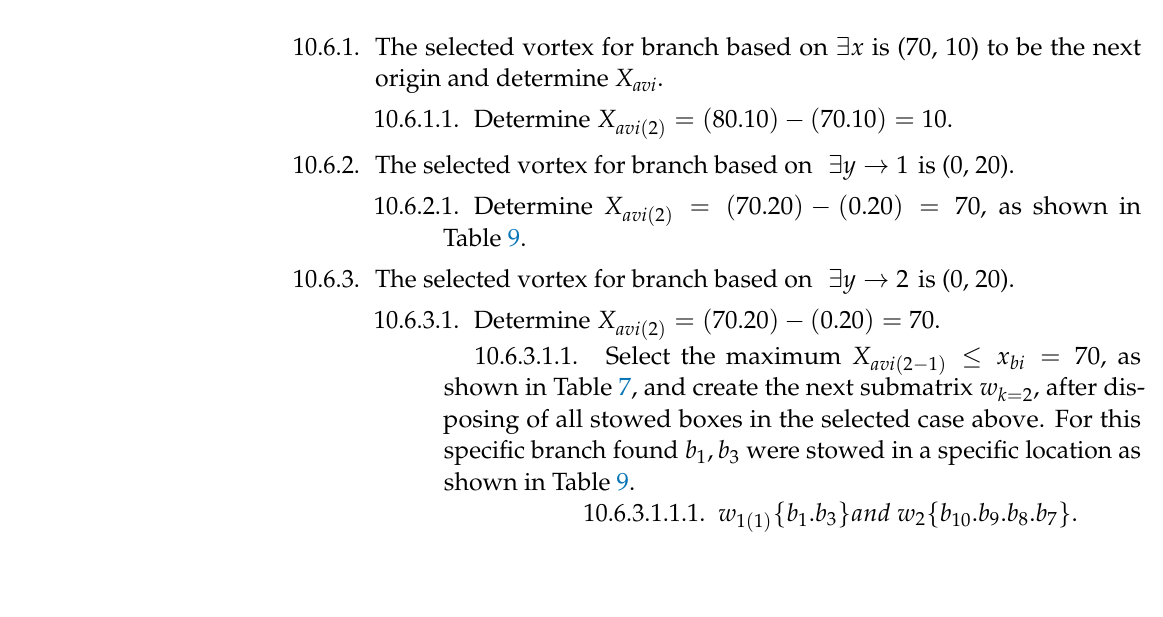
shown in Table 7, and create the next submatrix w k = 2 , after dis- posing of all stowed boxes in the selected case above. For this specific branch found b 1 , b 3 were stowed in a specific location as